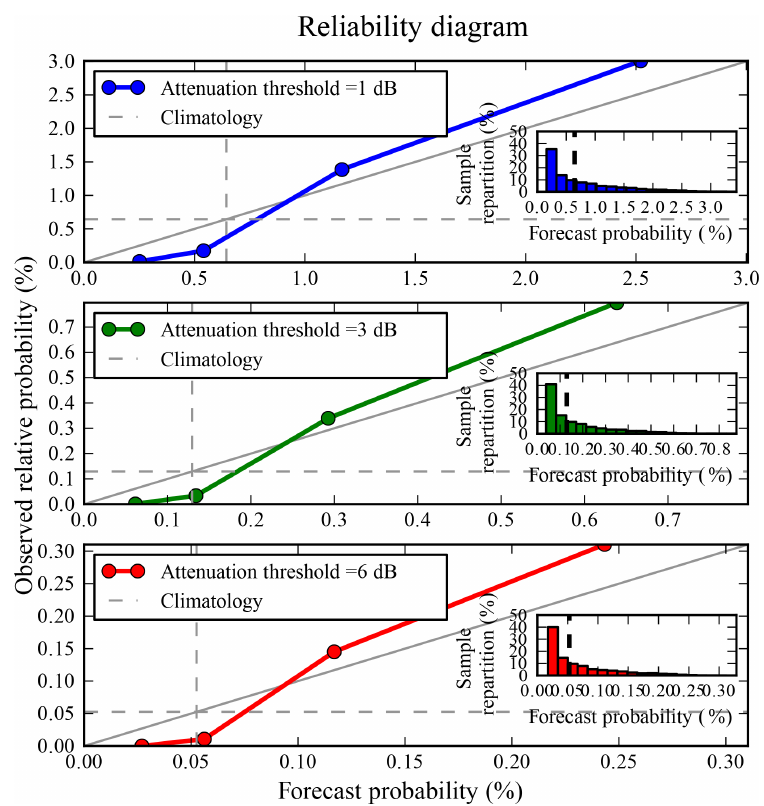
Figure 5. Reliability diagrams showing observed relative frequency as a function of forecast probabilities for attenuation thresholds 1dB (blue), 3dB (green) and 6dB (red). Inset boxes indicate the frequencies of use of the forecasts. The dotted lines represent the climatological probability. By convention, the horizontal dashed line represents the climatological probability of the event in the observations. The vertical dashed line represents the climatological probability in the forecast.